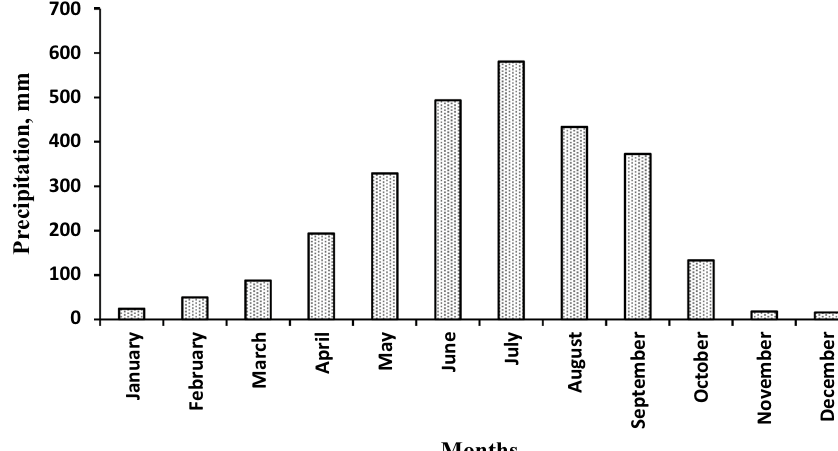
Fig. 2 Monthly variation in precipitation in the study